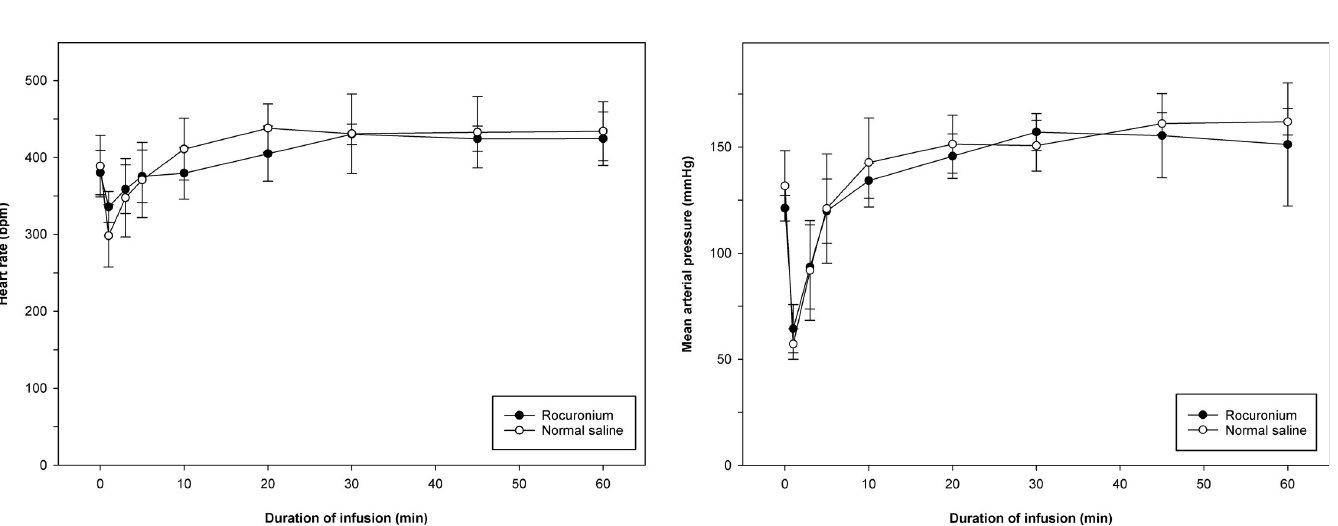
Fig 2. Mean arterial pressure (mmHg) and heart rate (beats per minute [bpm]) measured at bolus injection of propofol (time 0) and at 1, 3, 5, 10, 20, 30, 45, and 60 min after initiating propofol infusion with rocuronium or normal saline. (A) Mean arterial pressure after initiating propofol infusion with rocuronium did not differ significantly from that with normal saline at any time point. (B) Heart rate after initiating propofol infusion with rocuronium did not differ significantly from that with normal saline at any time point.